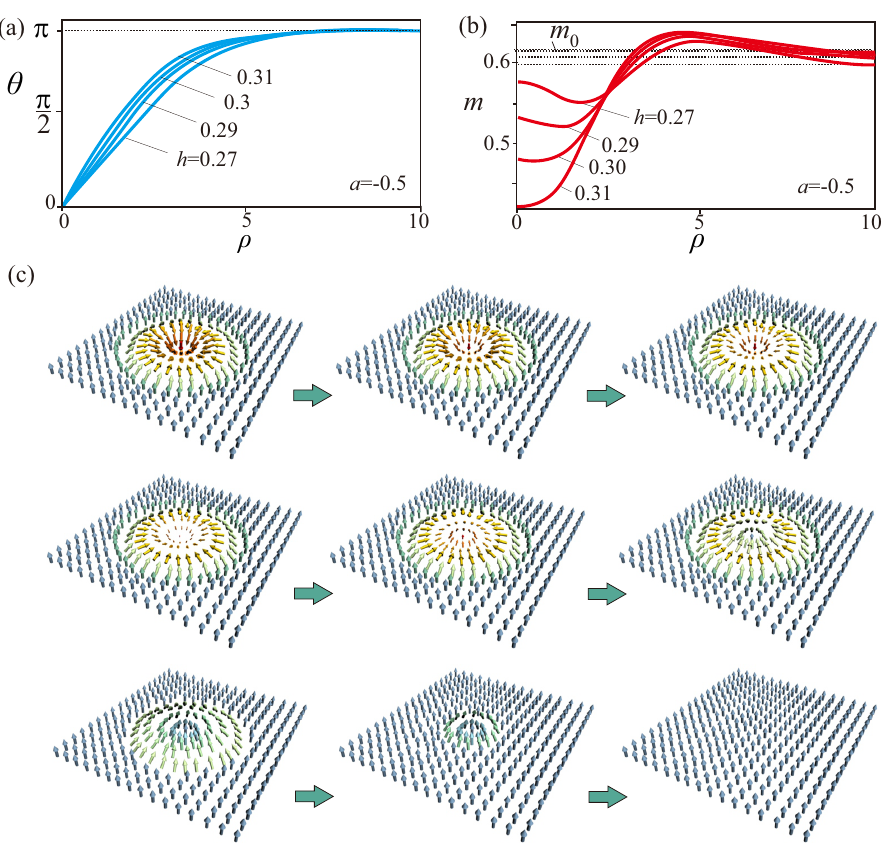
Figure 2. (color online) Increasing magnetic field applied to isolated skyrmion ( a = − 0.5) localizes profiles θ ( ρ ) ( a ) and leads to the disappearance of isolated skyrmions by squeezing out modulus m 1 in the center ( b ). ( c ) Snapshots showing skyrmion transformation into the homogeneous state. The modulus m 1 in the skyrmion center gradually decreases, passes through zero and appears on the other side being aligned along the field. Although one can obtain solutions for the whole process, skyrmions collapse once the modulus approaches zero